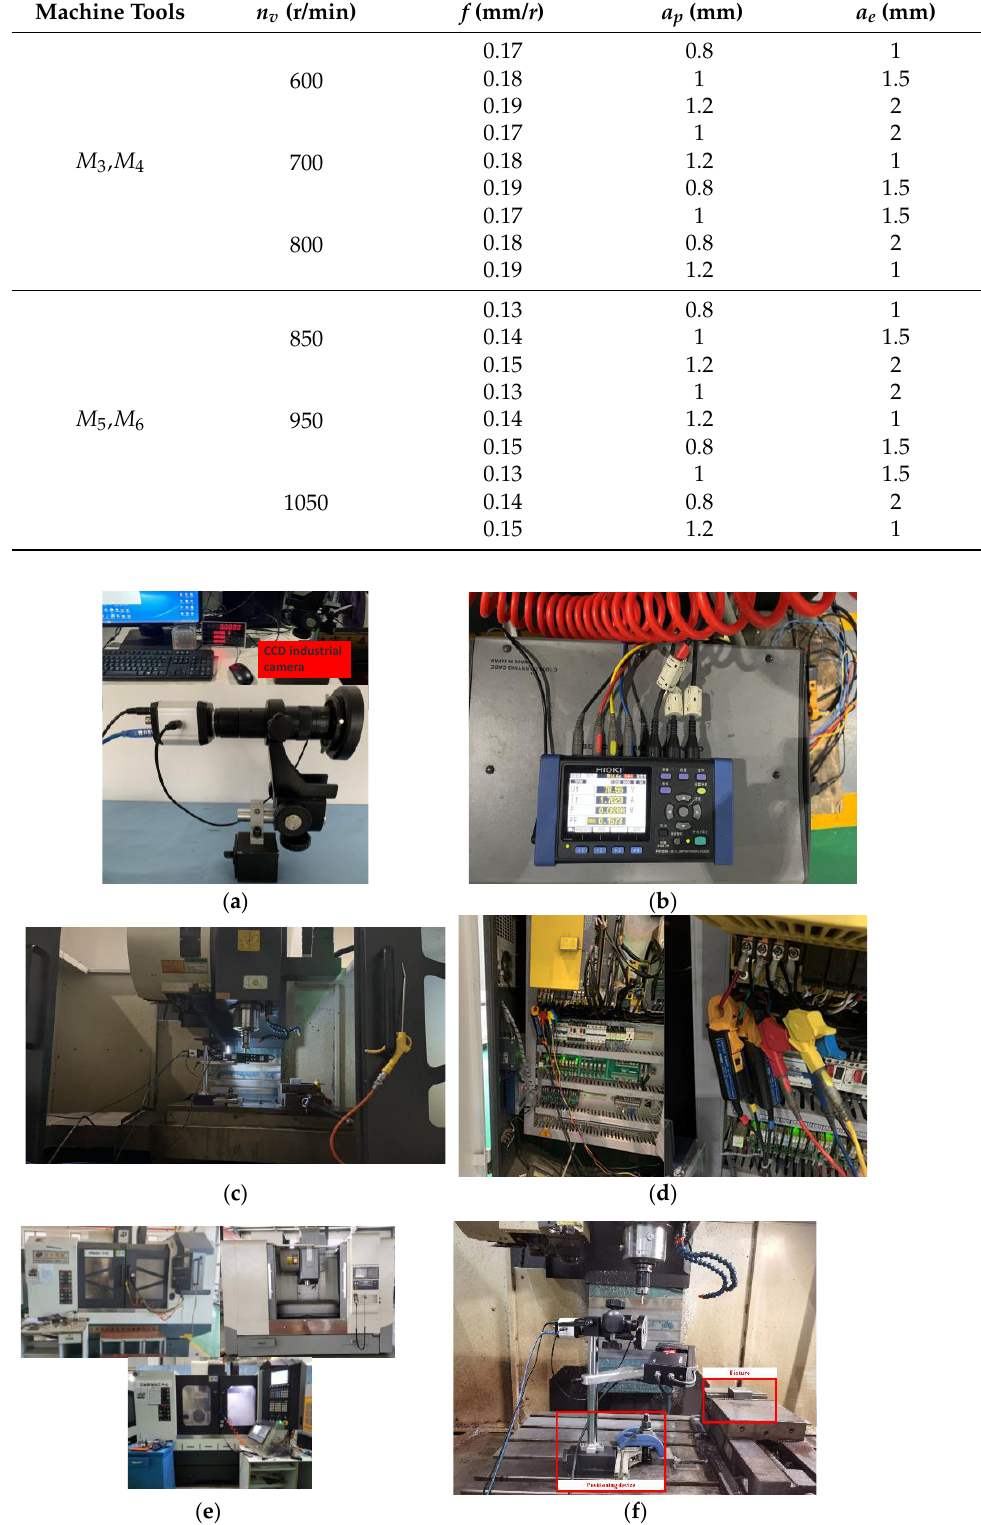
Figure 16. Experimental device: ( a ) Tool wear detection device; ( b ) Clamp on power logger (PW3360A982-04); ( c ) Tool wear detection process; ( d ) Power acquisition wiring diagram; ( e ) CNC machining center (M 1/2 ,M 3/4 ,M 5/6 ); ( f ) Positioning device and fixture. During the milling process, cutting-tool wear was detected once per ten cuts accord- ing to the cutting route. When the end point of the cutting-tool wear was reached, ma- chining was stopped and the tool was changed. Photos of the detected partial cutting-tool wear are shown in Figure 17. Figure 17. Partial tool wear detection photos. The multivariate linear regression method [33] was used to determine the parameters in the cutting-tool degradation model, as shown in Figure 18. The machining power and cutting-tool life models are shown in Table 4. 4.69mins 22.36μm